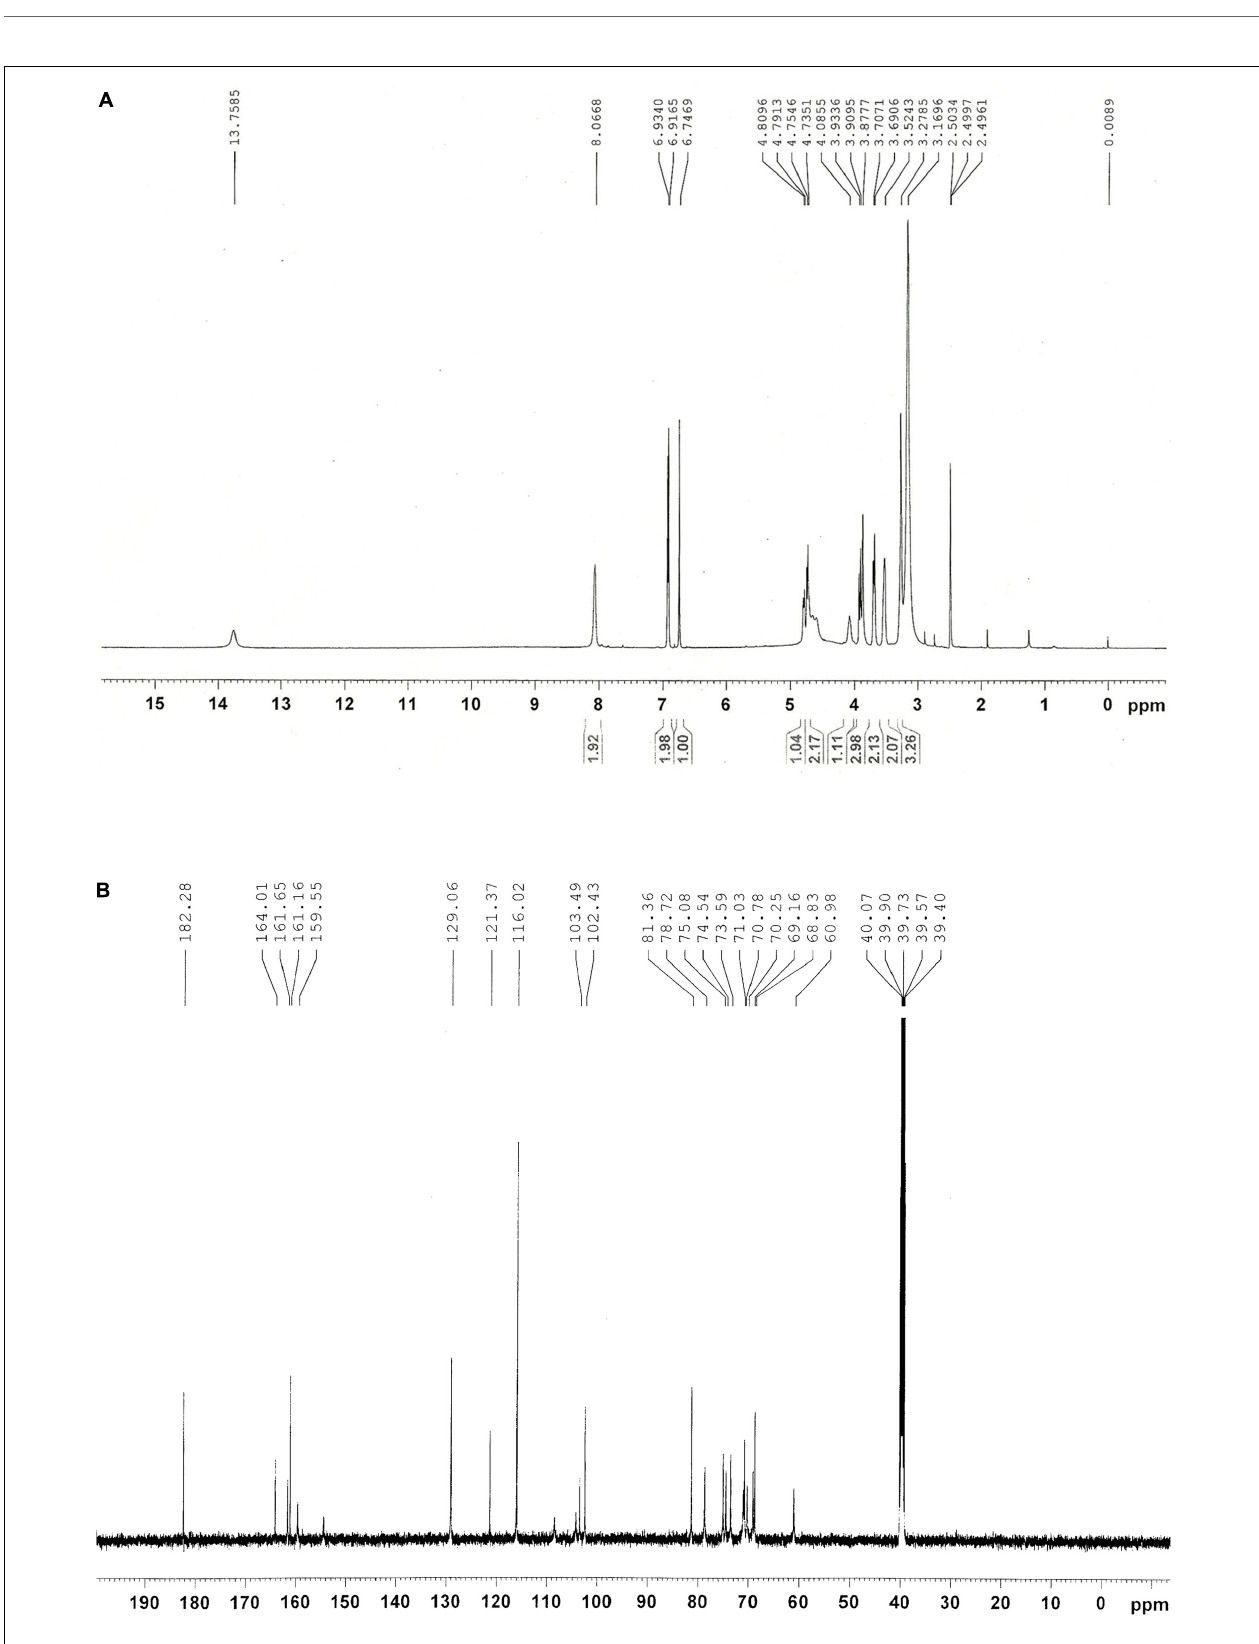
FIGURE 4 | NMR spectra of Peak 1 related compound schaftoside. (A) 1 H NMR spectra; (B) 14 C NMR spectra.